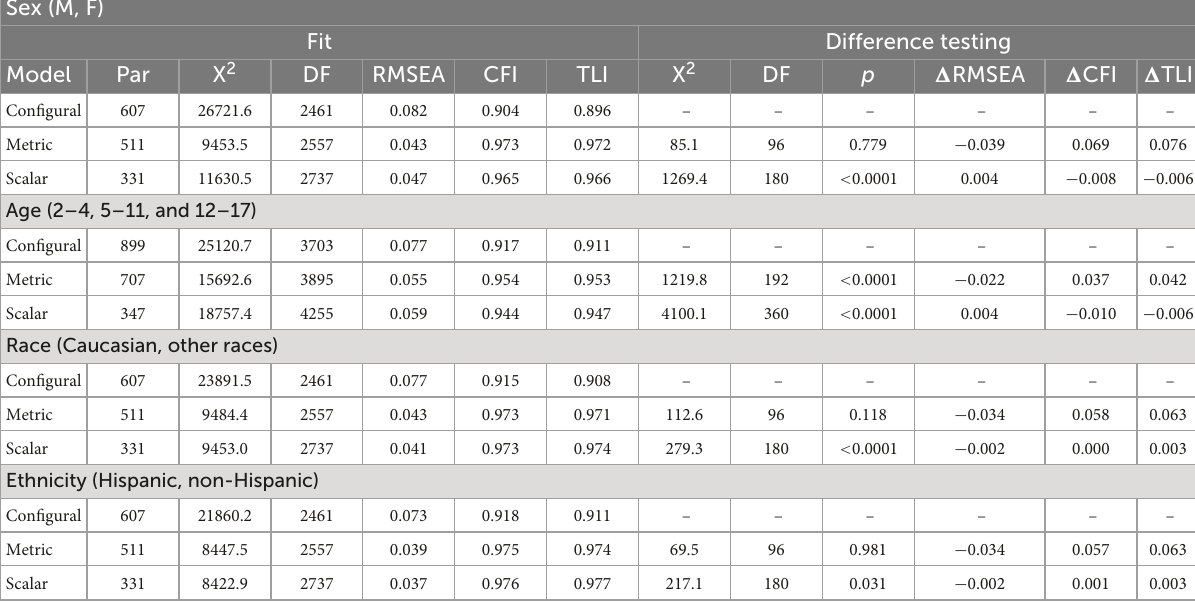
TABLE 2 Measurement invariance analyses for the executive functioning (EF) specific factor model across sex, age, race, and ethnicity. Sex (M, F) Fit Difference testing Model Par X 2 DF RMSEA Configural